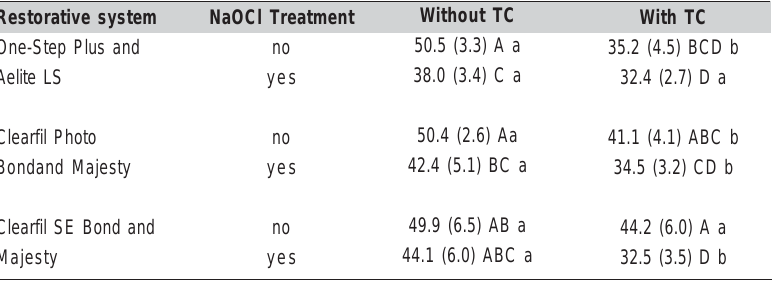
Table 3. Mean dentin bond strengths (standard deviation) of restorative systems (composite and adhesive) after thermocycling (TC) or not (in MPa).